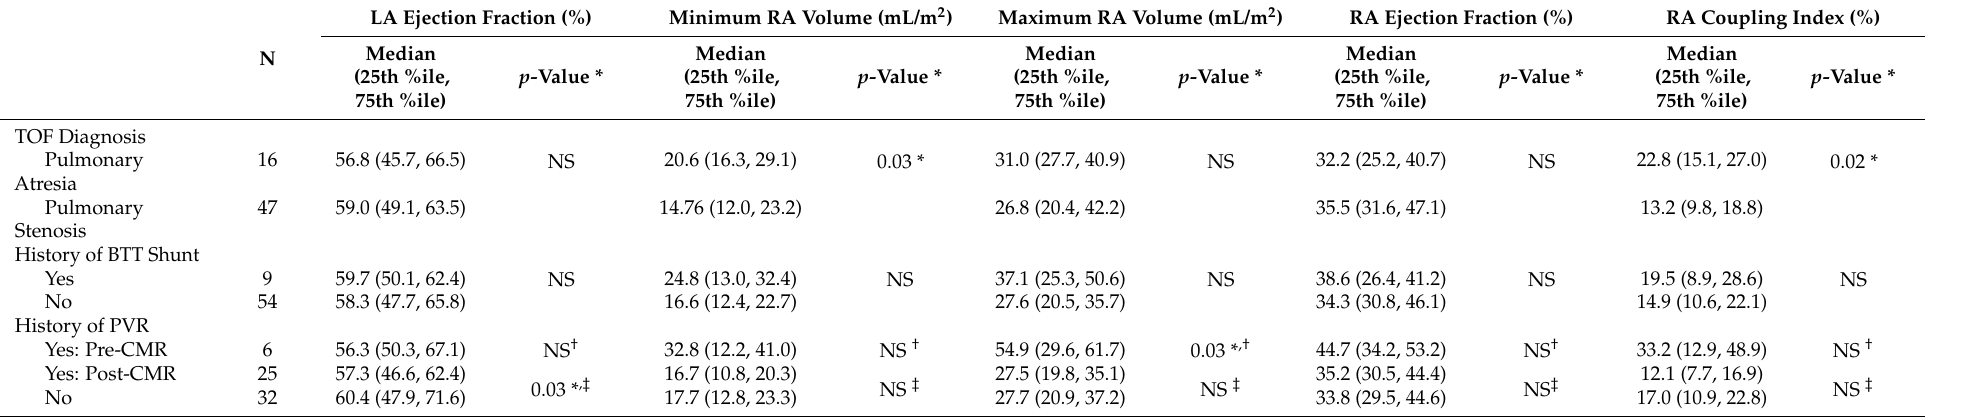
Table 3. Associations between atrial CMR measurements and patient